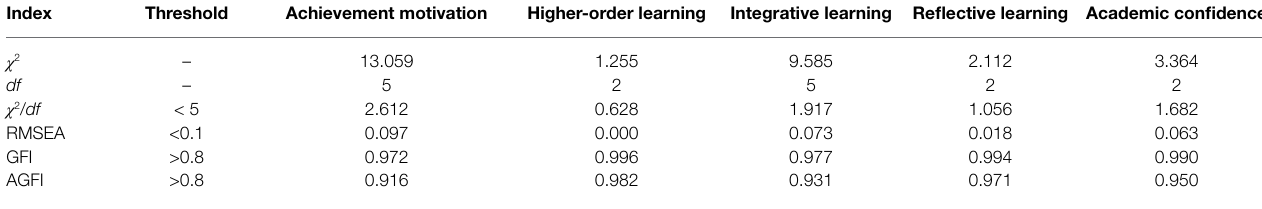
TABLE 2 | Item analysis by first-order confirmatory factor